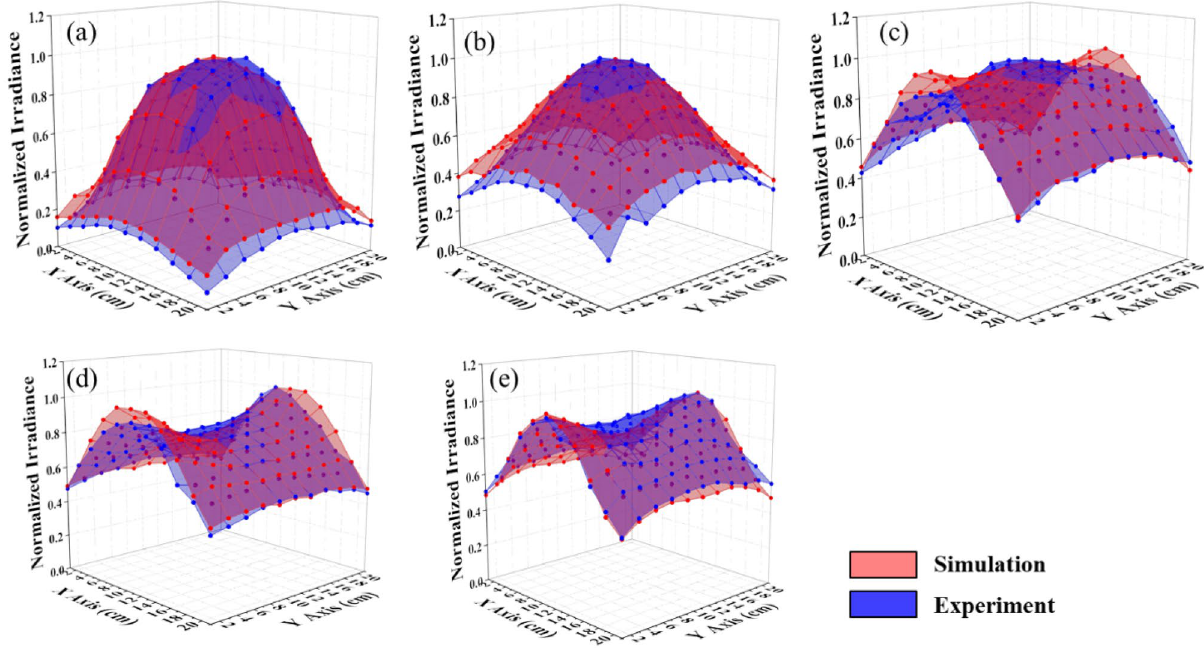
Figure 6. Comparison of the irradiance distribution of sections between simulation and experiment in normalization at different heights ( a ) 25, ( b ) 20, ( c ) 15, ( d ) 10, and ( e ) 5 cm with NCC as 99.7, 99.2, 97.0, 95.1, and 95.6%,